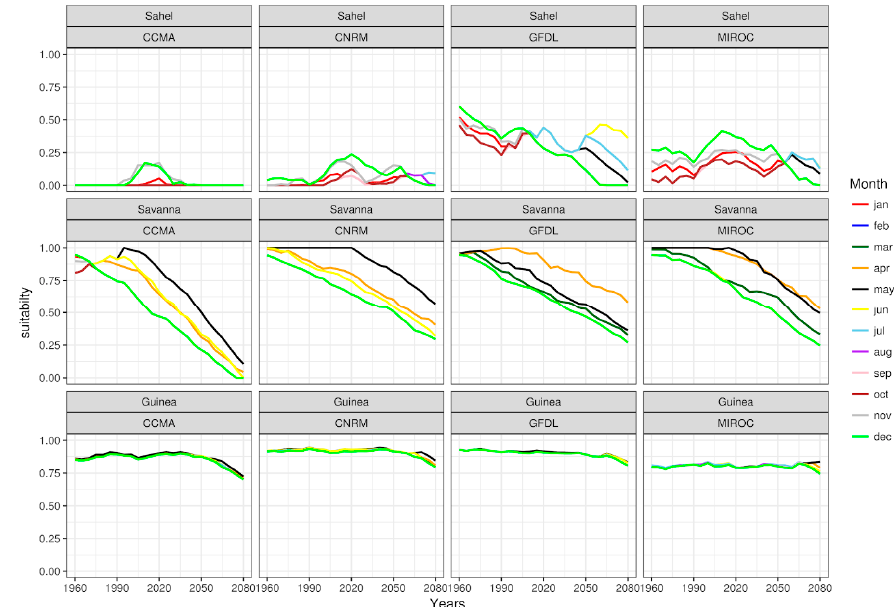
Figure 5. Cassava planting month suitability plots in the Guinea, Sahel, and Savanna as simulated by the four GCMs (CCMA, CNRM, GFDL, and MIROC) used as climate inputs into the Ecocrop suitability model.